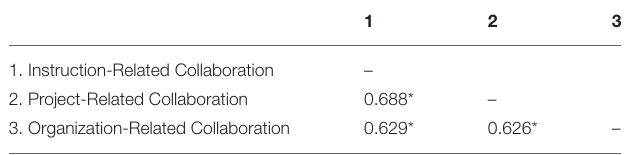
TABLE 1 | Correlation between collaboration